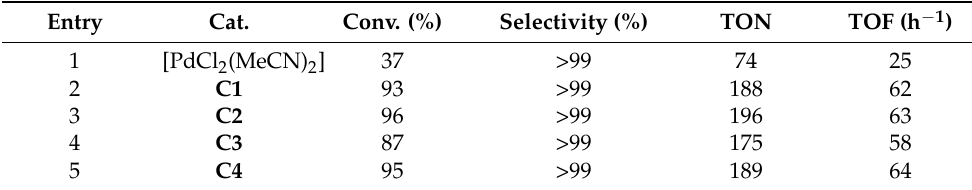
Figure 21. Suzuki ‐ Miyaura coupling of bromobenzene with phenylboronic acid under optimum conditions. Table 9. Results obtained from Suzuki ‐ Miyaura coupling of bromobenzene with phenylboronic acid under optimum conditions.